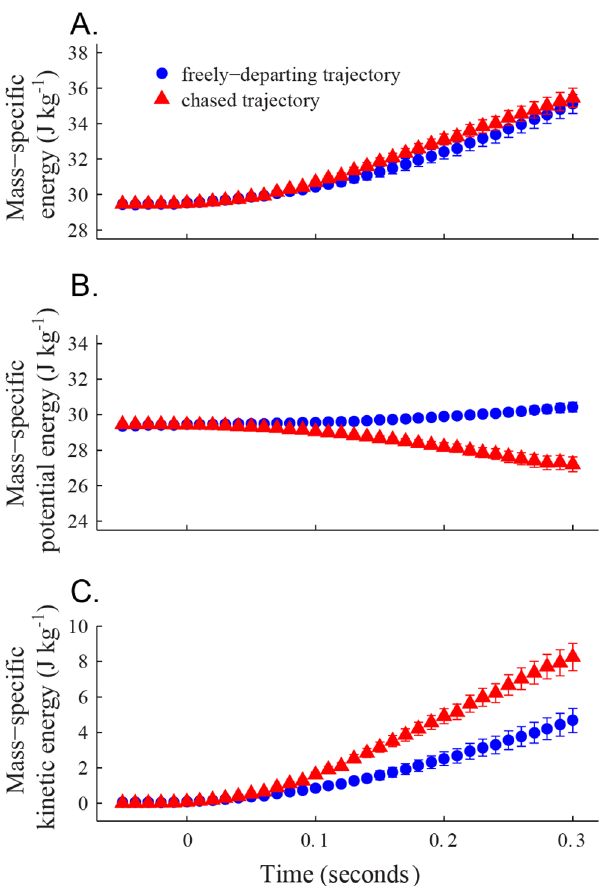
Fig 7. Kinetic and potential energy in departure trajectories. Here we show the (A) mass-specific energy, (B) potential energy, and (C) kinetic energy of hummingbird trajectories departing from the feeder location under different conditions. The red triangle markers show the chased bird after departing the feeder (n = 31 trajectories at t c = 0 and n = 30 at 0.29 seconds). The blue circle markers show trajectories from freely- departing birds (n = 15). The starting positions of all departing trajectories were set to the same value (3m above the ground) to provide a common point of comparison for changes in